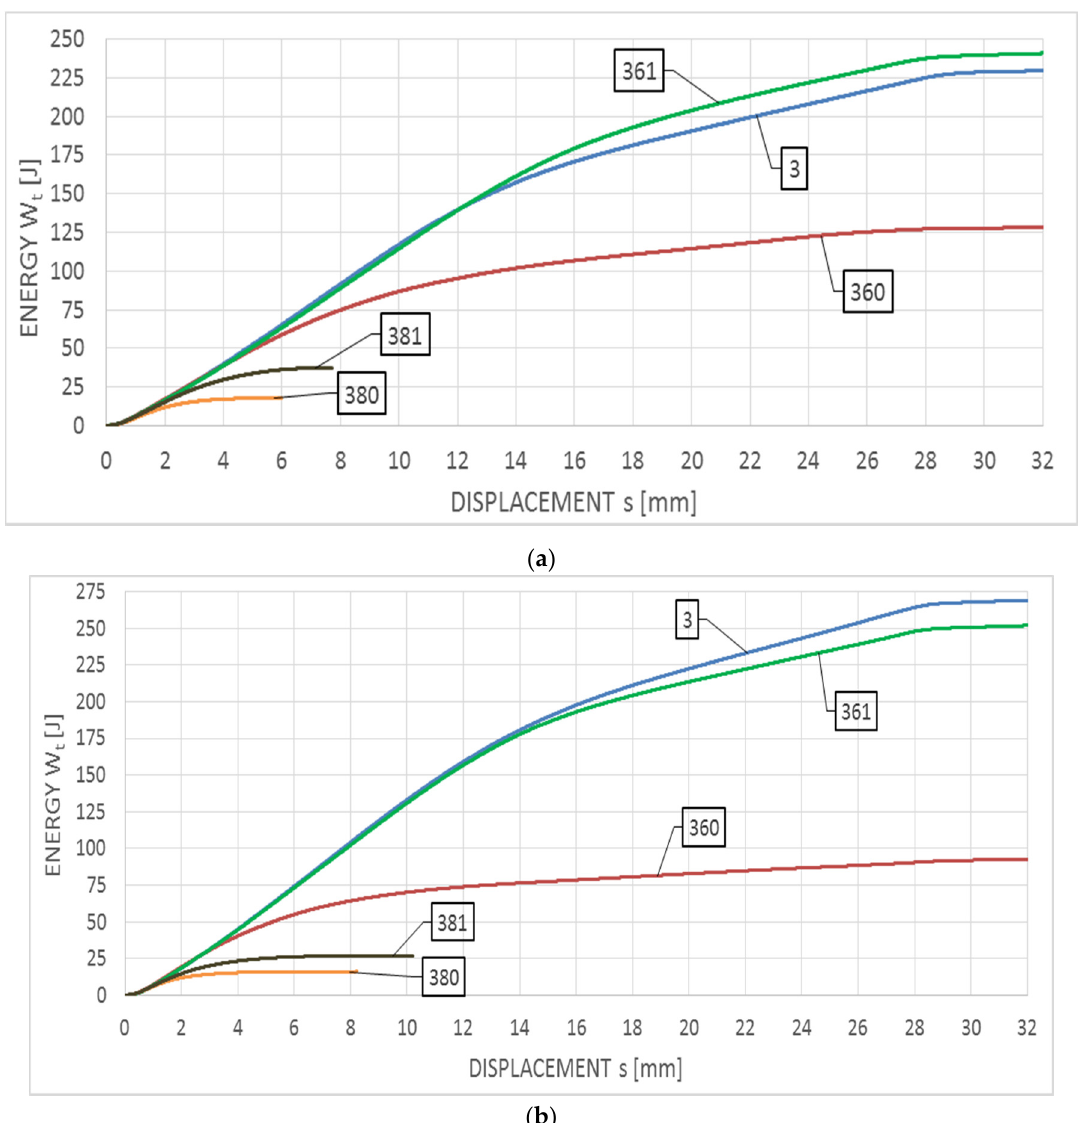
Figure 13. Averaged W t − s curves obtained on samples made of X2CrNiMoN22-5-3 steel: ( a ) during tests conducted in +20 °C, ( b ) during tests conducted in − 20 °C.